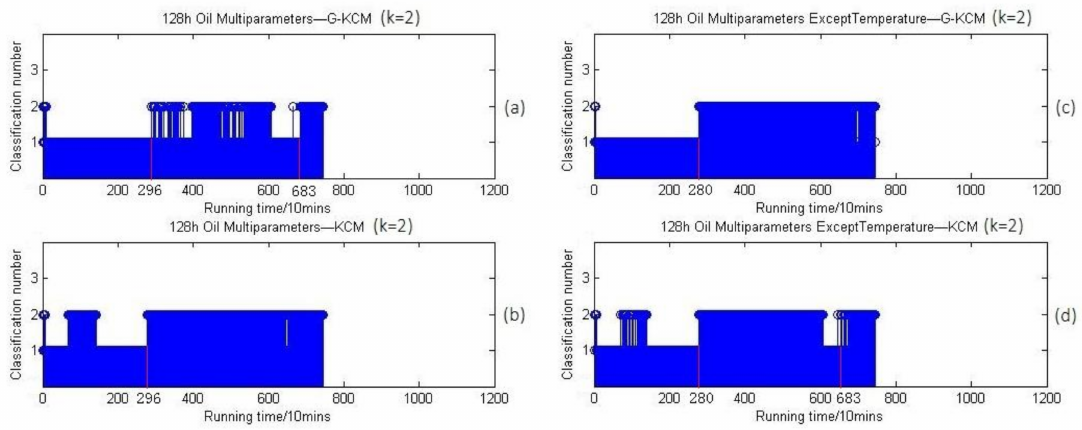
Figure 21. ( a ) 2-Clustering results of oil parameters within 128 h based on G-KCM; ( b ) 2-Clustering results of oil parameters within 128 h based on KCM; ( c ) 2-Clustering results of oil parameters except temperature within 128 h based on G-KCM; ( d ) 2-Clustering results of oil parameters except temperature within 128 h based on